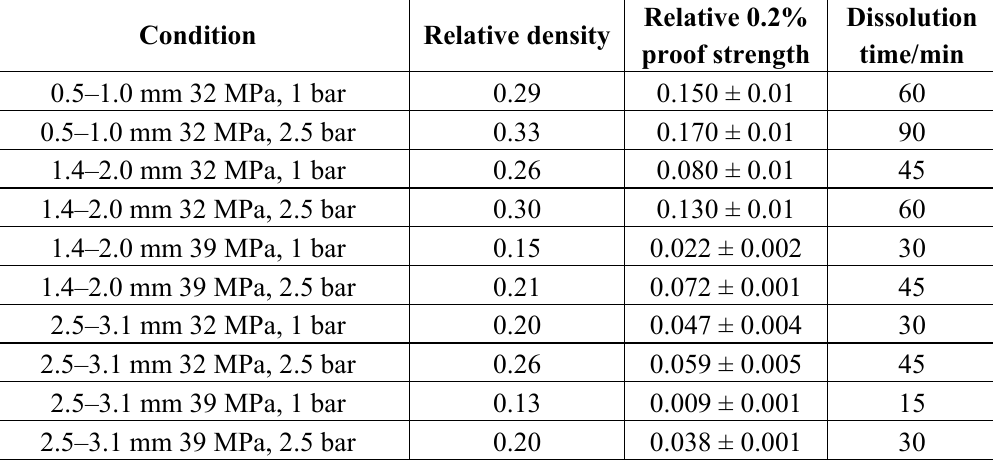
Table 2. Relative densities and relative 0.2% proof strengths for foams made from different bead sizes and preform compaction and infiltration